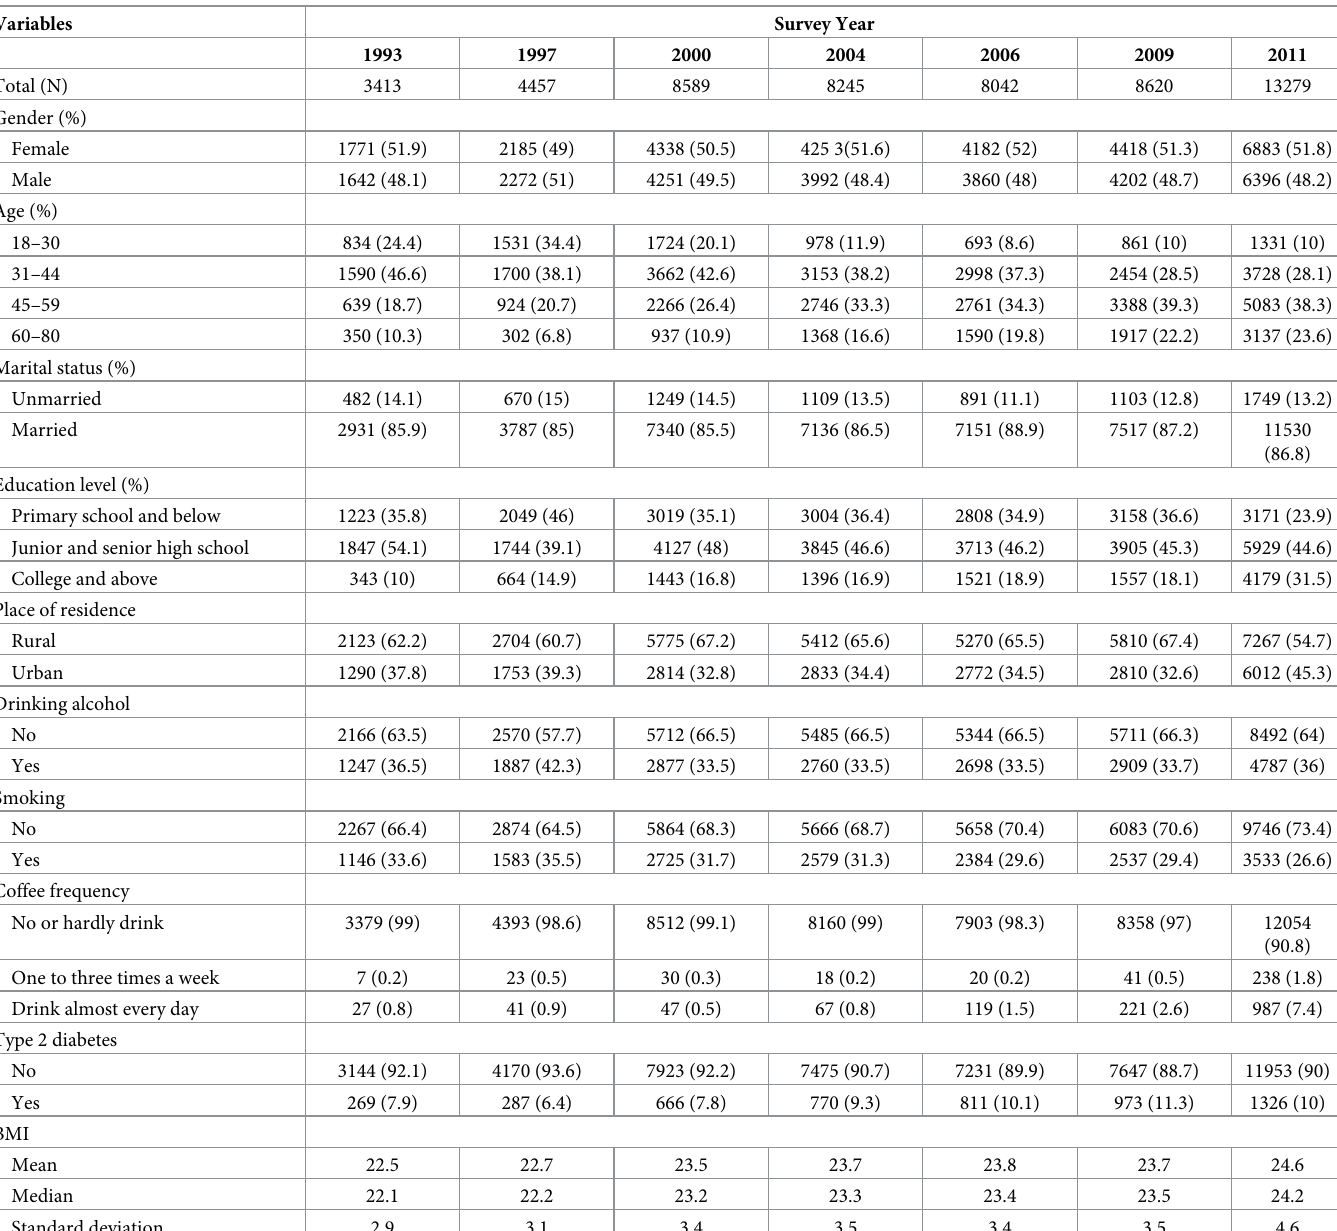
Table 2. Demographic characteristics of